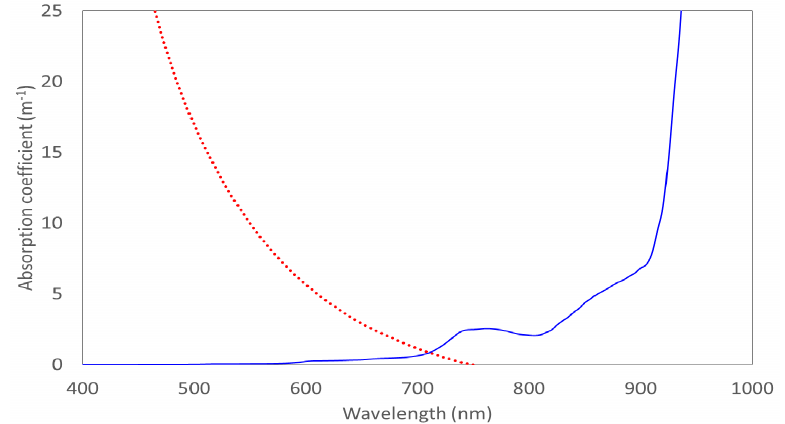
Figure 10. Absorption coefficient of CDOM from lake Nohipalu Mustjärv (red graph) and pure water absorption spectrum (blue line) [5].